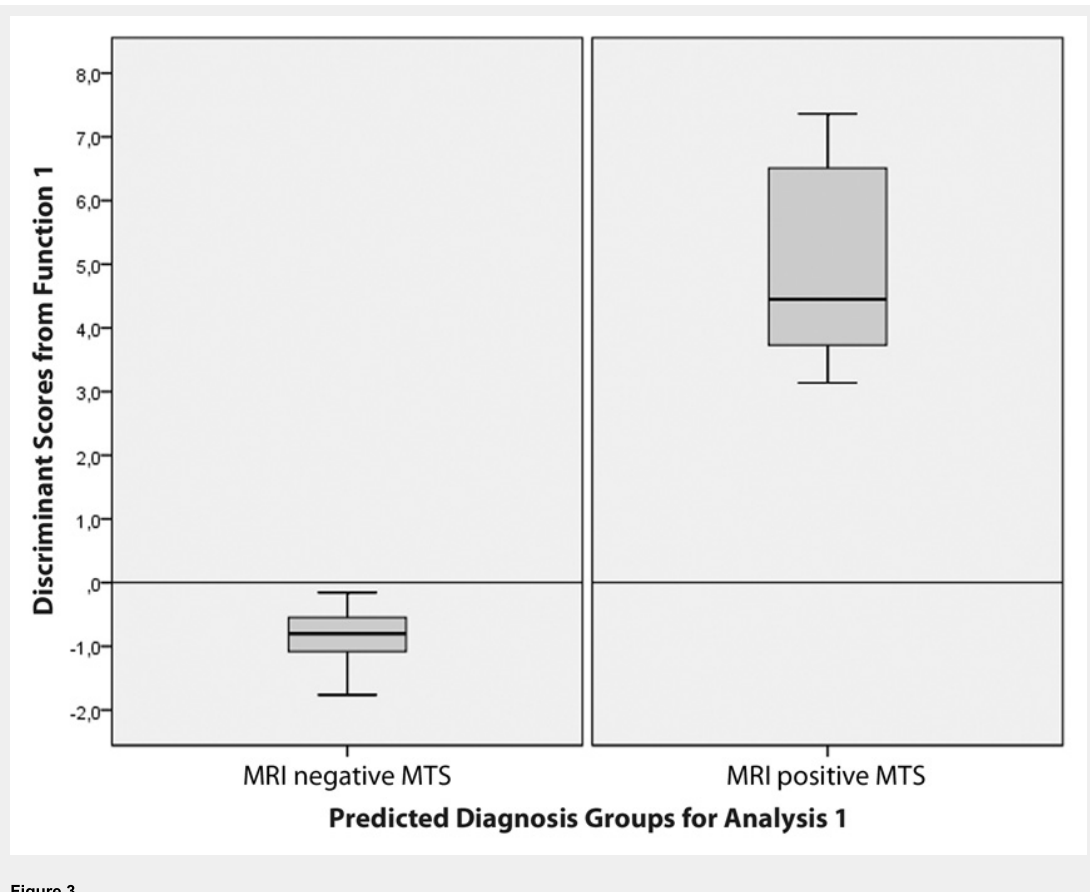
Box plots of the average D scores of DA illustrate the distribution of the discriminant function scores for each group. There is a visual demonstration of an excellent discrimination by showing the absence of overlap between